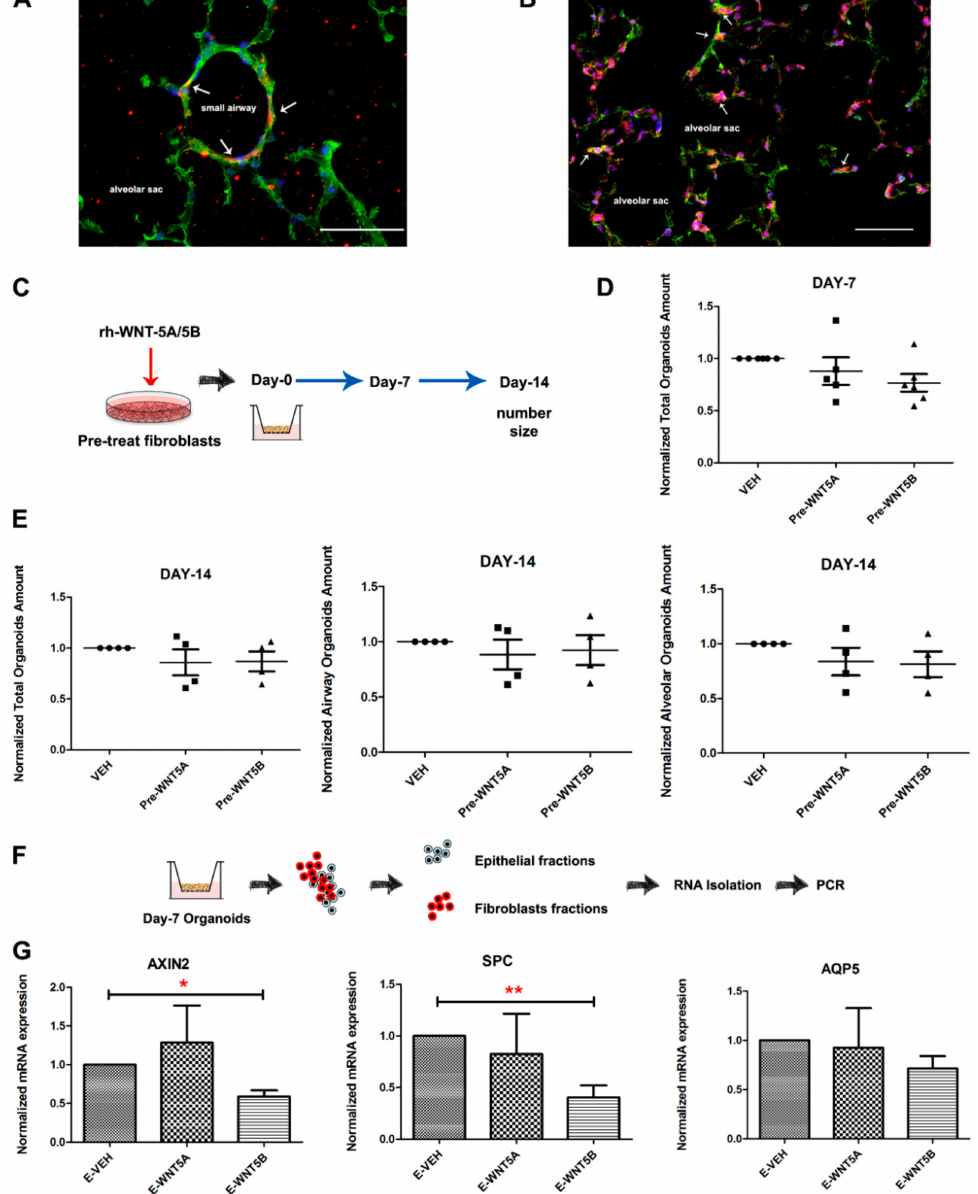
Figure 6. Delayed WNT-5A or WNT-5B signal supported from fibroblasts has no impact on organoids formation. ( A – B ) Representative images of murine lung slices stained with WNT-5A (left) / WNT-5B (right) and vimentin. Green (WNT-5A / 5B), red (Vimentin), blue (DAPI). ( C ) Schematic of mouse organoid experimental design with the pre-treatment of fibroblasts. ( D ) Quantification of total murine organoids on day 7 generated from co-culture CCL206 fibroblasts pre-treated with WNT-5A or WNT-5B (0 and 50 ng / mL). ( E ) Quantification of total, airway type, and alveolar type of murine organoids on day 14 generated from co-culture with CCL206 fibroblasts pre-treated with WNT-5A or WNT-5B (0 and 50 ng / mL). ( F ) Schematic of experimental design with re-sorting organoids study. ( G ) Normalized gene expression of AXIN2, SPC, and AQP5 on epithelial fractions derived from the organoids cultured 7 days with WNT-5A or WNT-5B (0 and 50 ng / mL). Data are expressed as mean ± SEM, * p < 0.05, ** p <